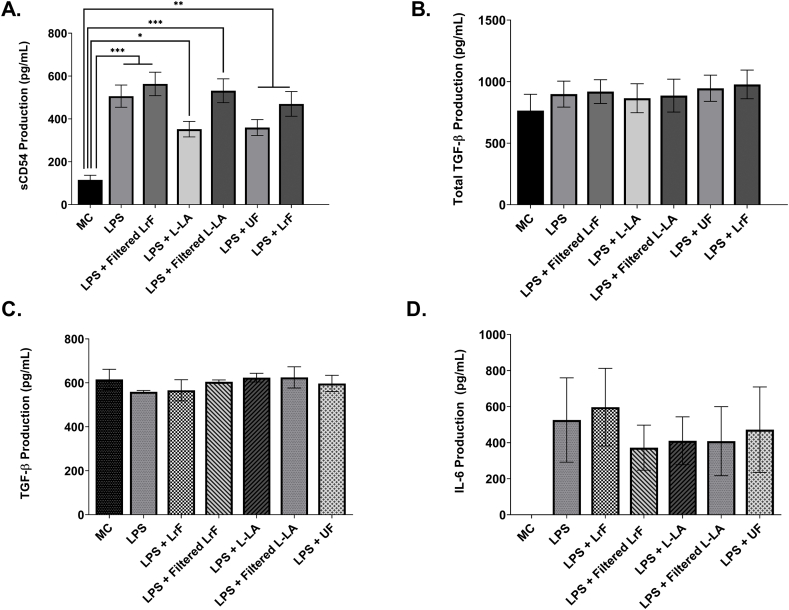
Supplemental Figure 1. U937 and THP-1 macrophages stimulated with 125 ng/mL LPS and incubated with L. rhamnosus R0011 whole/filtered ferments or milk controls concurrently for 24 h (n = 3) A. Mean sCD54 production from U937 macrophages ± SEM B. Mean TGF-β production ± SEM from U937 macrophages C. Mean TGF-β production from THP-1 macrophages ± SEM and D. Mean IL-6 production from THP-1 macrophages ± SEM. Cell viability was >80% for all treatments, as determined by Trypan Blue Exclusion Viability assays. Significance between treatment groups as determined by Tukey's one-way ANOVA is indicated as ∗ (P < 0.05), ∗∗ (P < 0.01), ∗∗∗ (P < 0.001), or ∗∗∗∗(P < 0.0001).